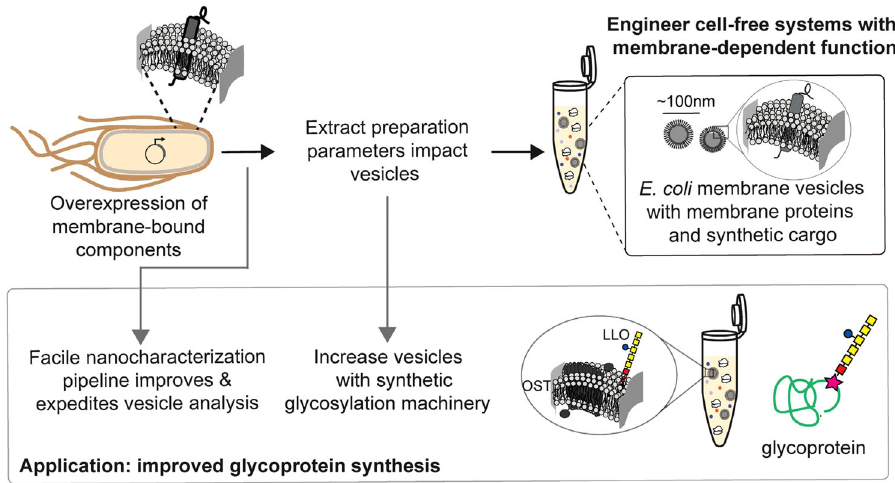
Fig. 1 A platform for engineering cell-free gene expression (CFE) systems with cell-derived membrane-dependent functions. Membrane-bound cargo expressed in living E. coli is carried through into CFE extracts via membrane vesicles. The extract preparation method used to prepare CFE extracts impacts sizes and concentrations of vesicles, and their associated cargo. Here, we develop a facile nanocharacterization pipeline to better understand and characterize the impacts of extract preparation methods on vesicle pro fi les and their associated cargo. We then apply our fi ndings to improve cell-free glycoprotein synthesis (CFGpS), which is a promising platform for on-demand vaccine development. By increasing concentrations of vesicles and membrane-bound glycosylation machinery, oligosaccharyltransferases (OSTs) and lipid-linked oligosaccharides (LLOs), we overcome limitations in CFGpS and increase glycoprotein titers.